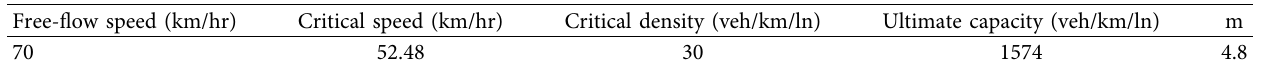
Table 2: Key parameters in the Los Angeles case.